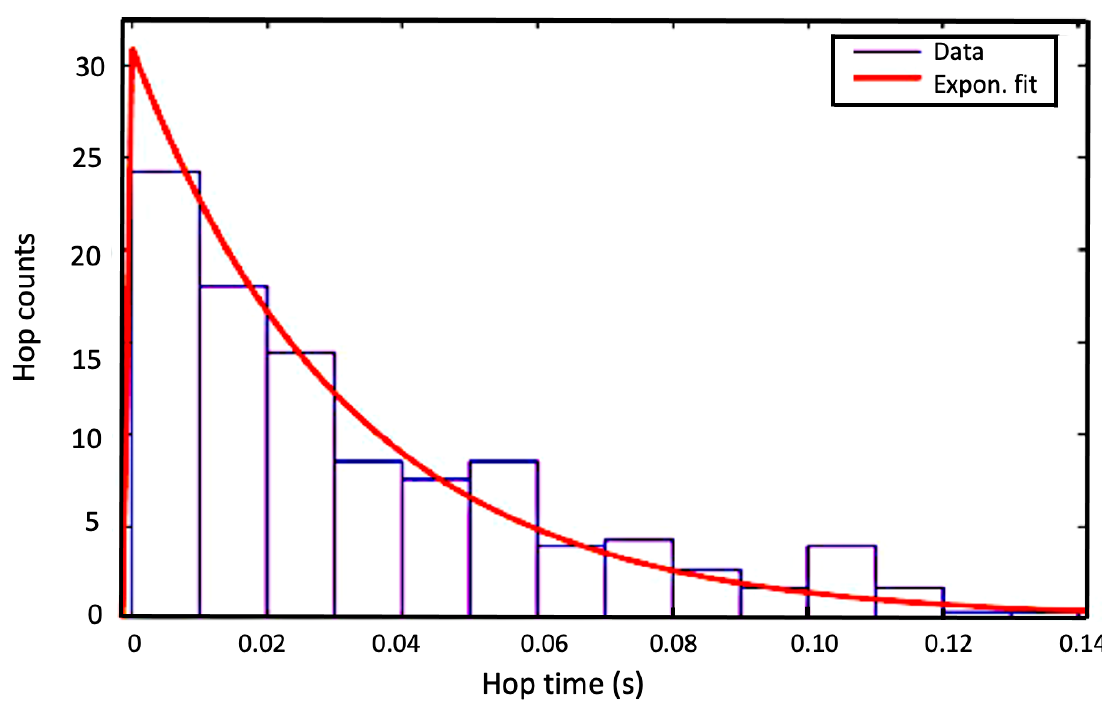
Figure 9. Distribution of empirical hop travel time data and corresponding best fit model (exponential probability density function) for the flow rate of 52.5 (L/s), particle density of 1180 (kg/m 3 ), and bed surface B.